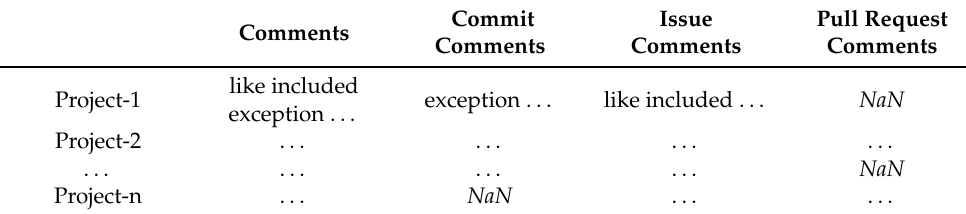
Table 5. A sample project-developer matrix belongs to